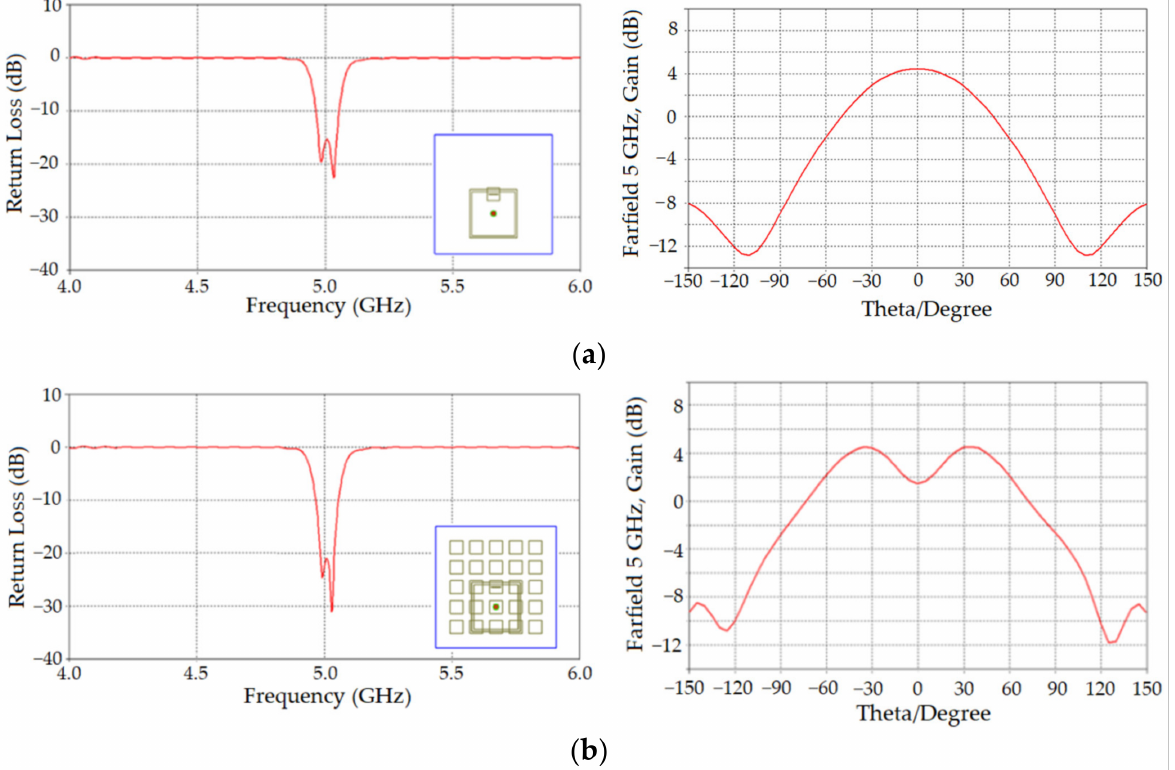
Figure 2. Simulated return loss and gain pattern of the proposed antenna with the parameters’ value in Table 1: ( a ) single patch; ( b ) 5 × 5 patches array.